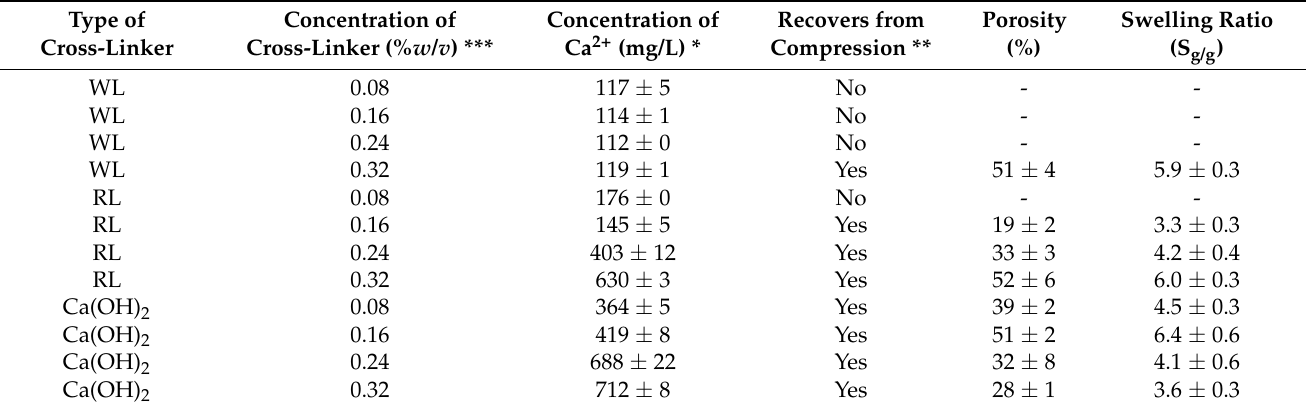
Figure 2. FE-SEM images of the cryogels prepared using various amounts of Ca(OH) 2 in limewater prepared at least three days earlier and with three freeze thaw cycles. Table 1. Porosity and swelling ratio of the cryogels ( n = 3).